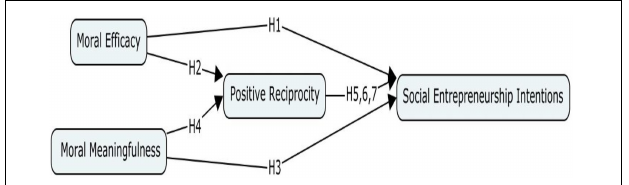
FIGURE 1 | Theoretical